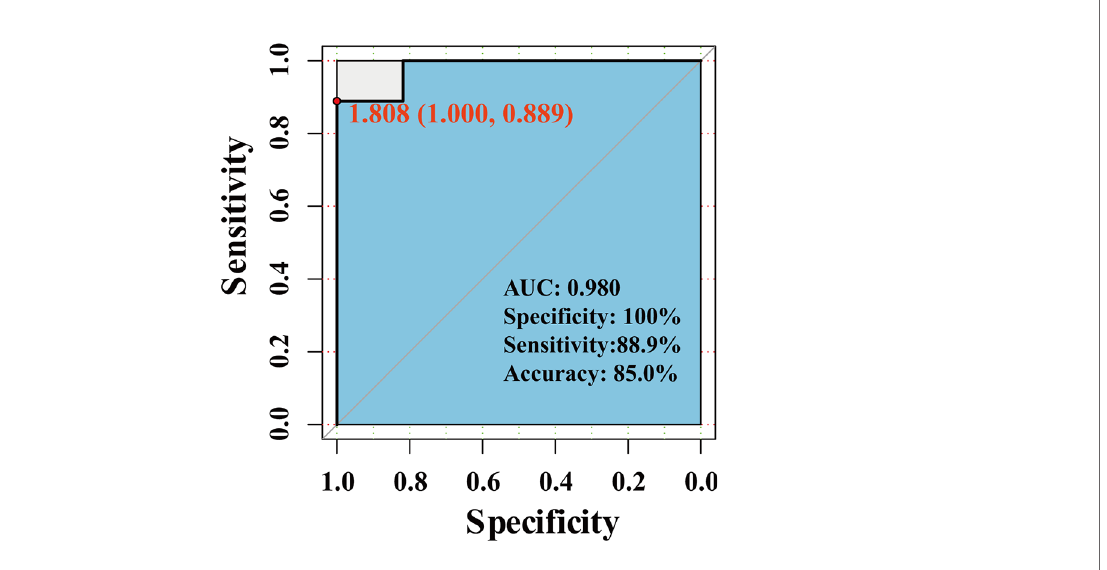
FIGURE 7 | The Roc curve of the combined ten hub genes in predicting RIF.